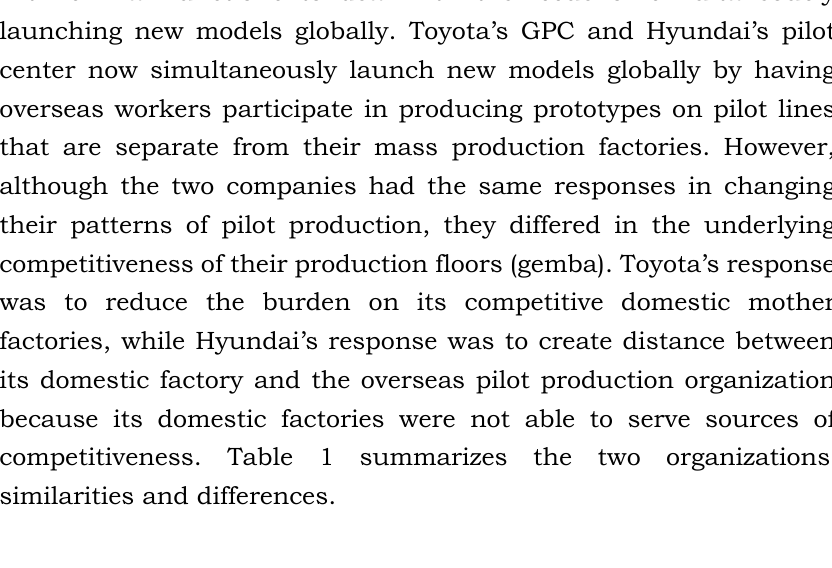
1 summarizes the two organizations’ similarities and